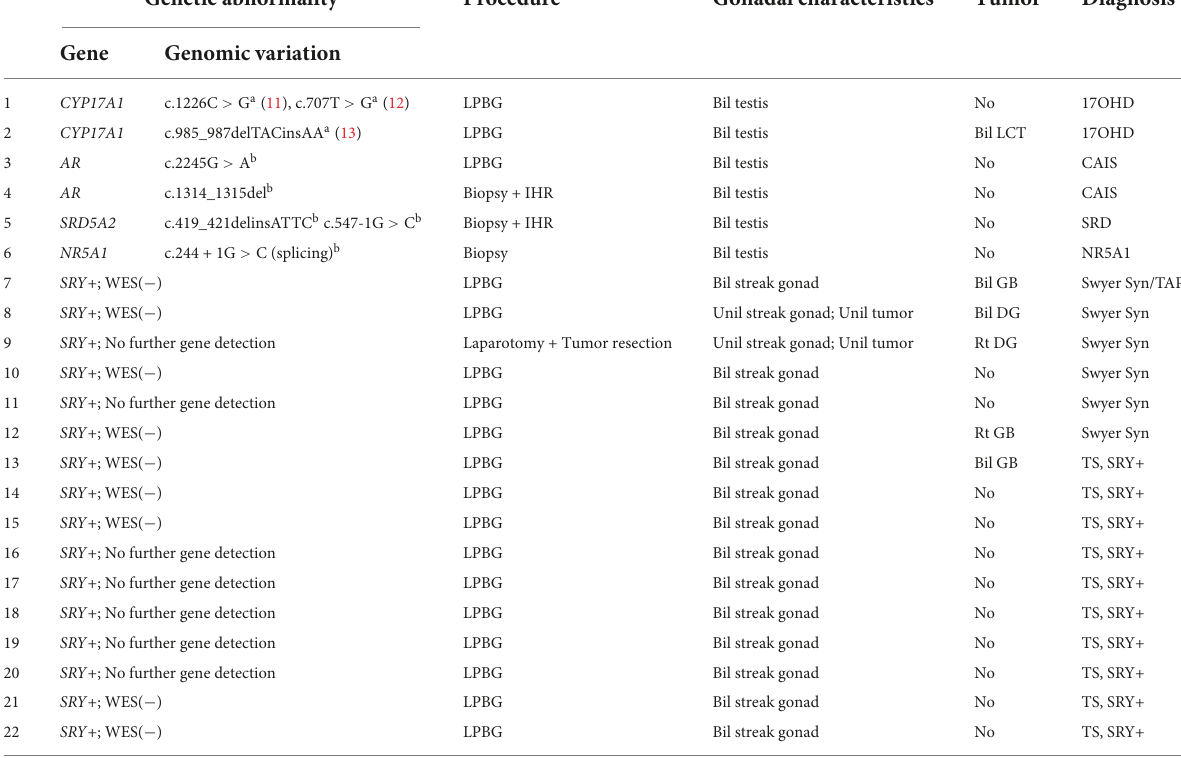
TABLE 2 Genetic abnormalities, procedures, pathological results, and diagnoses of the gonadal samples. Genetic abnormality Procedure Gonadal characteristics